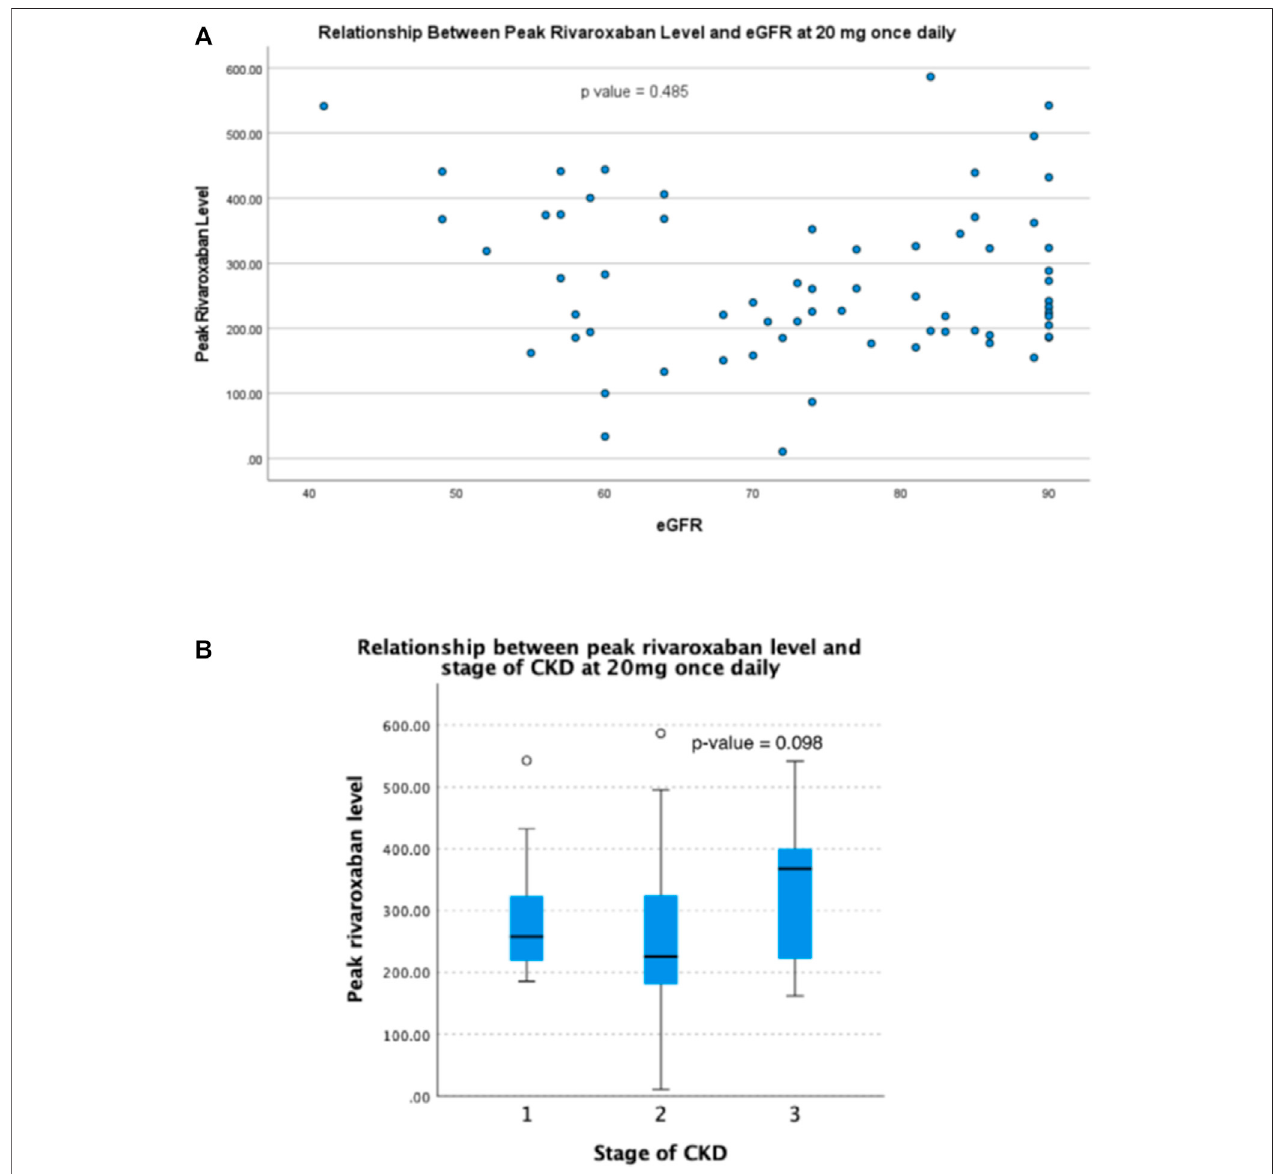
FIGURE 2 | Relationship between peak plasma rivaroxaban level and (A) eGFR and (B) stage of CKD in patients receiving rivaroxaban 20 mg once daily.